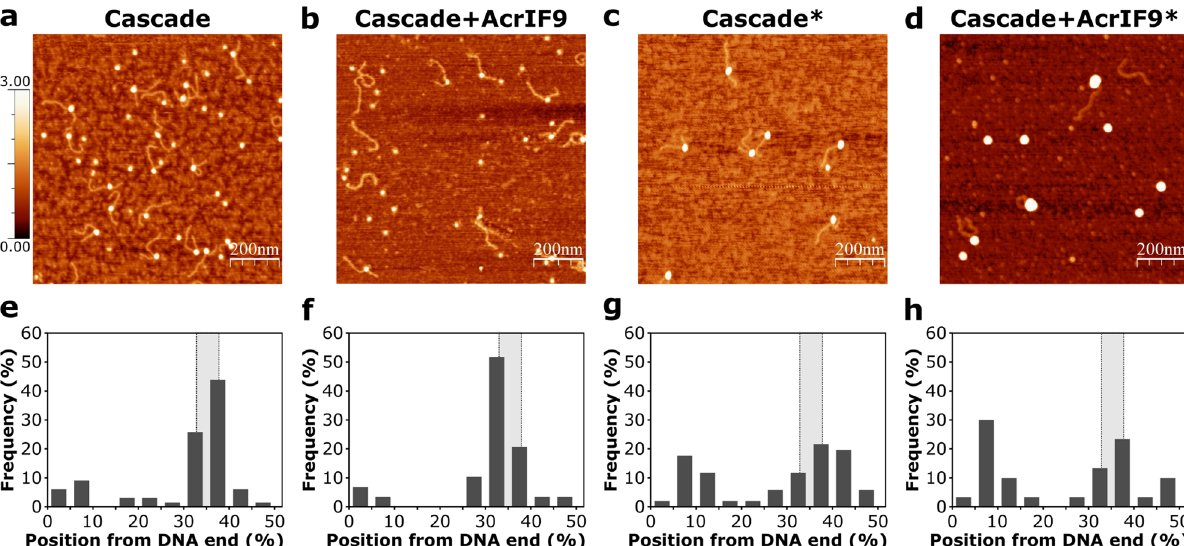
Figure 3. Cascade and AcrIF9-Cascade binding distribution on DNA monitored by AFM. ( a – d ) Representative AFM images of the protein-DNA interaction complexes. Scan size 1 µm by 1 μm (additional images and magnified views are provided in Supplementary Figs. S7 and S8, respectively). ( e – h ) Protein binding distribution on the DNA. The percentage histogram indicates the frequency of the binding events according to the binding sites, which were obtained by measuring the distance from the centre of a bound protein to the shorter DNA end. ( a , e ) Cascade (number of analyzed complexes—n = 66) and ( b , f ) AcrIF9-Cascade (n = 29) binding to DNA in the absence of the cross-linker. ( c , g ) Cascade (n = 51) and ( d , h ) AcrIF9-Cascade (n = 30) binding to DNA in the presence of the cross-linker (2% (v/v) of glutaraldehyde; indicated by asterisk).